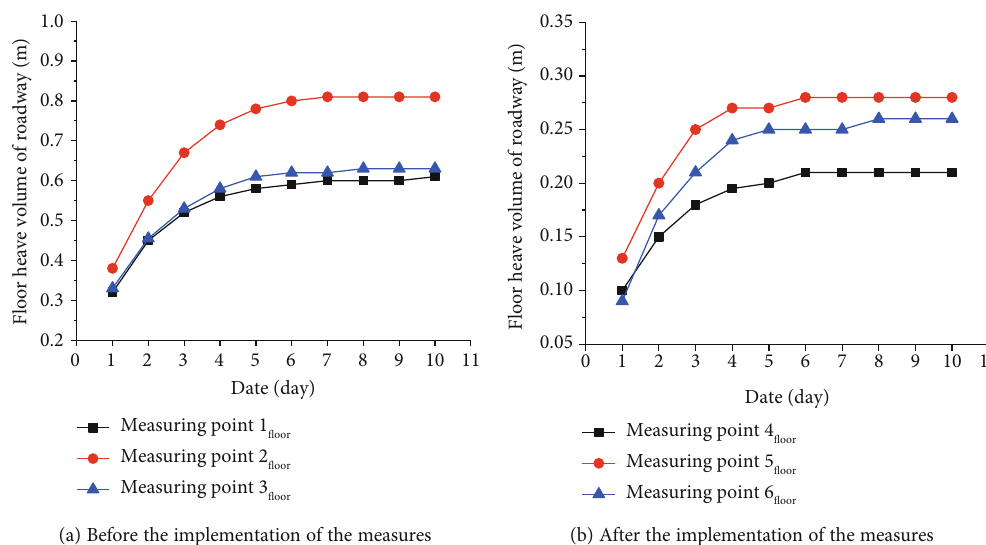
Figure 19: Comparison of the fl oor heave volume before and after the implementation of anti-scour measures on the working face. 0.40.60.81.01.2